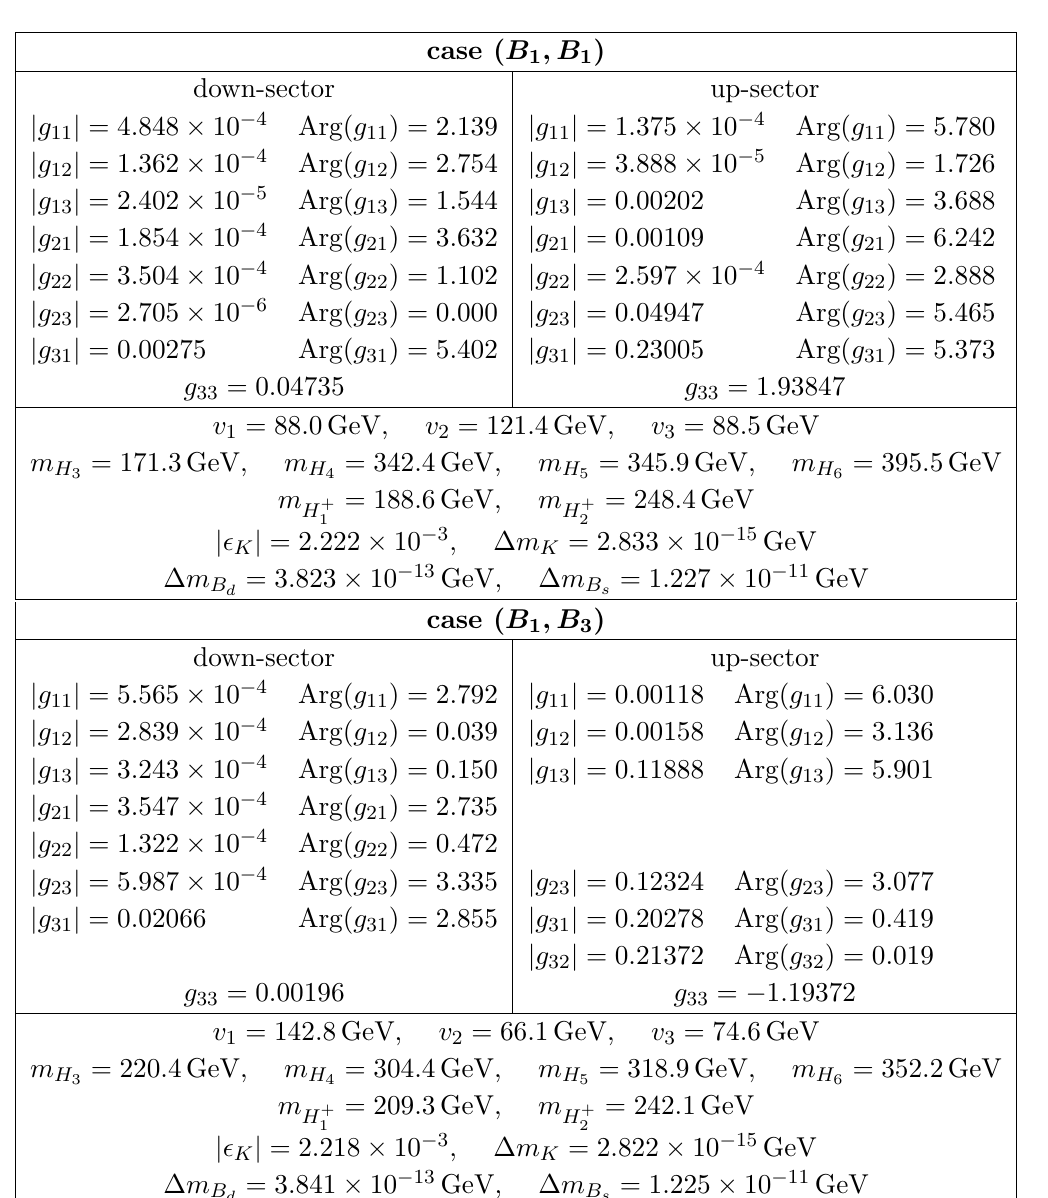
Table 1 . Two benchmark points for our model implementation in cases ( B 1 ; B 1 ) and ( B 1 ; B 3 ) and their resulting mass spectra and predictions for the (cid:13)avor